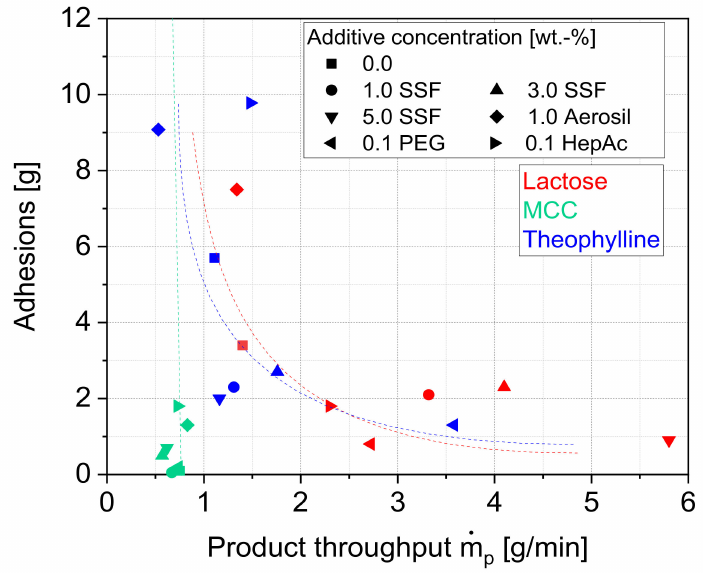
Figure 5. Relation between product throughput and product particle